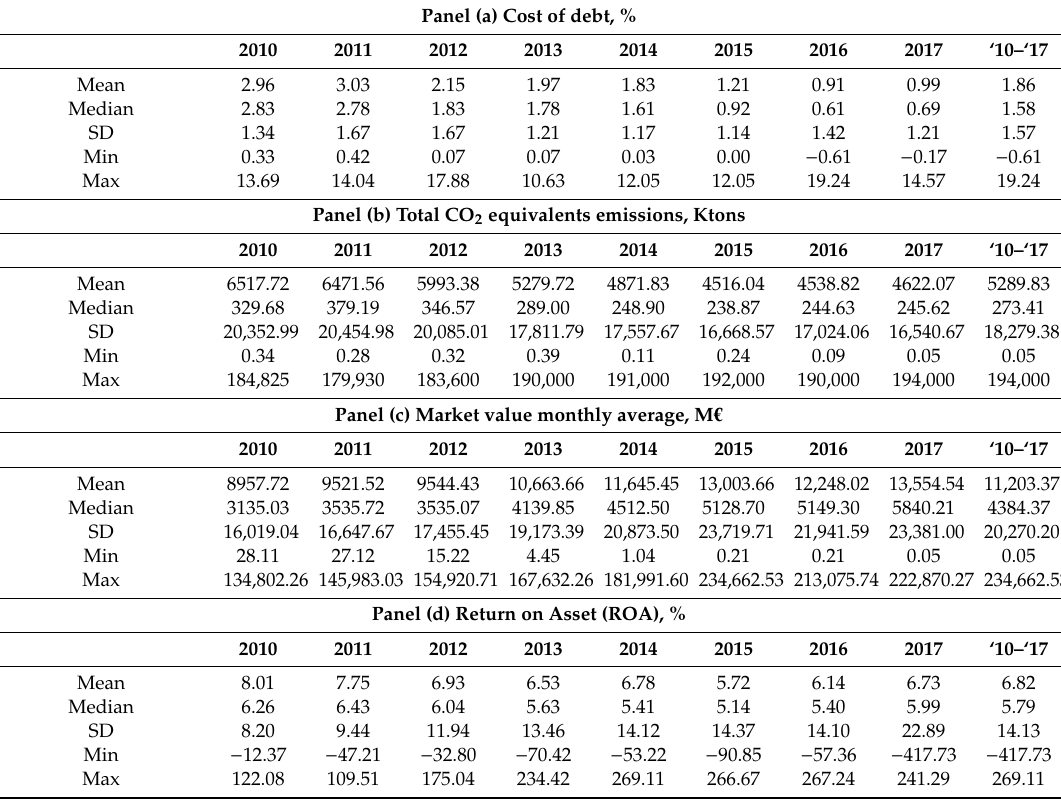
Table 1. Descriptive